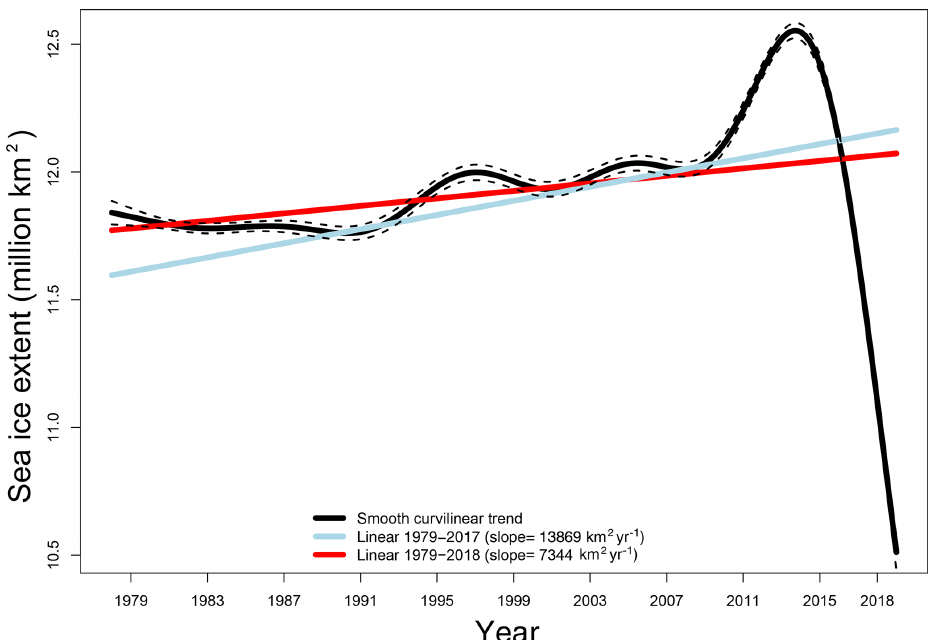
Figure 6. Three estimates of the trend in the recorded SIE represented in terms of the amount of SIE associated with the change. The blue line is the linear trend estimated for data from 1 January 1979 to 31 December 2017. The red line is the linear trend estimated for data from 1 January 1979 to 31 December 2018. The black line is the curvilinear trend estimated for data from 26 October 1978 to 31 December 2019. The dashed lines are the 95% pointwise confidence bands for the smooth curvilinear trend.